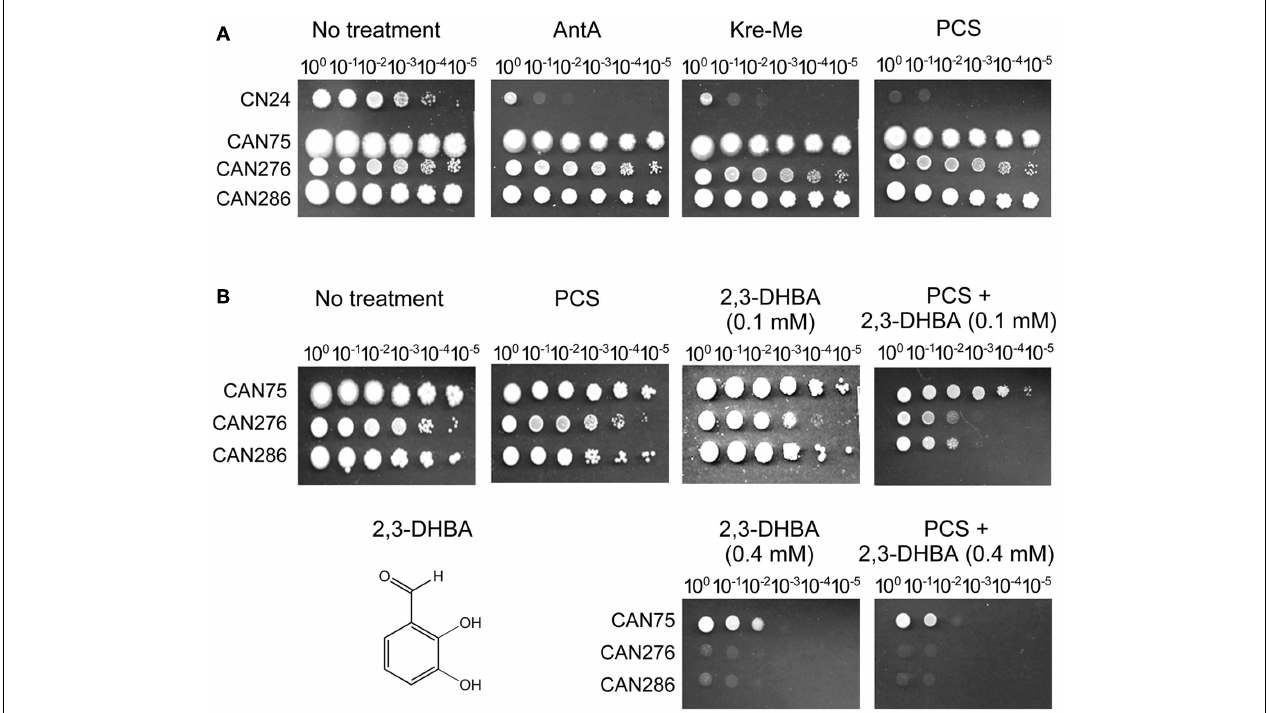
FIGURE 5 | Chemosensitization of pyraclostrobin (PCS), an inhibitor for complex III in mitochondrial respiratory chain (MRC) with 2,3-dihydroxybenzaldehyde (2,3-DHBA) in yeast pathogens. (A) Cryptococcus neoformans CN24 was relatively more sensitive to MRC inhibitors (100 μ gmL − 1 ) compared to other pathogens ( Candida albicans